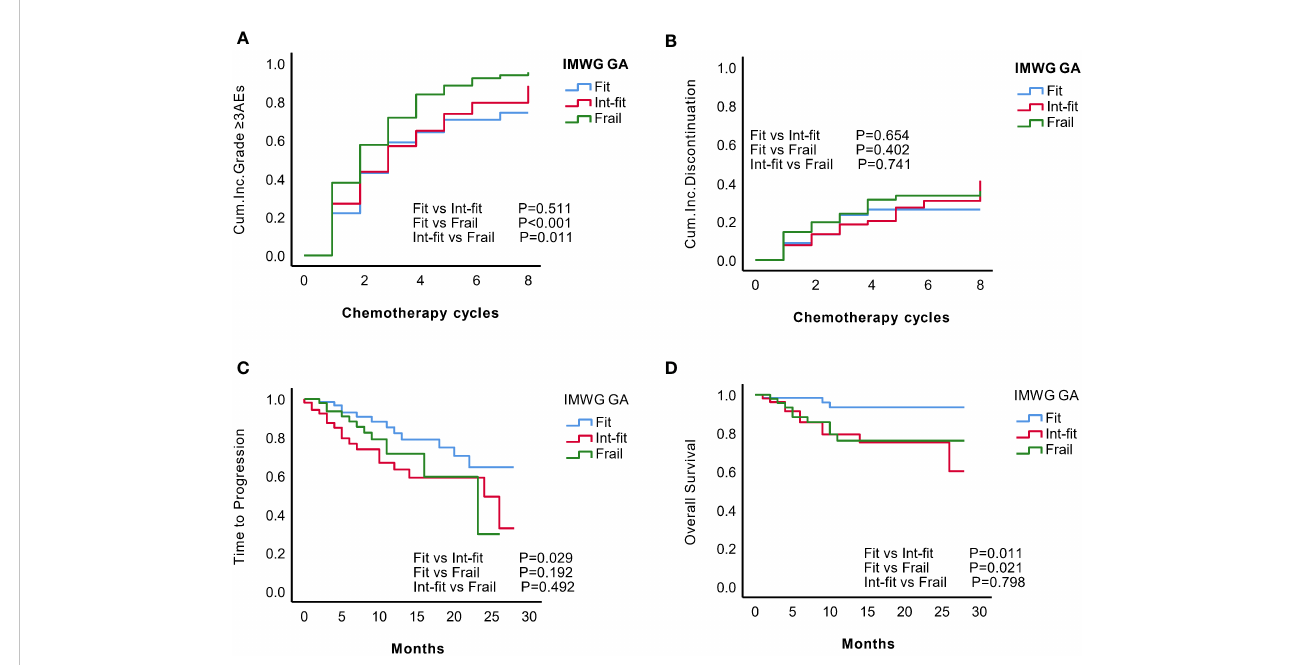
FIGURE 1 KM analysis of grade ≥ 3 AEs, treatment discontinuation, time to progression (TTP) and overall survival (OS) according to the IMWG GA subgroups. According to the IMWG GA evaluations, the patients were classi fi ed as fi t, int- fi t, or frail. The three subgroups were compared according to the (A) cumulative incidence of grade ≥ 3 AEs; (B) cumulative incidence of treatment discontinuation; (C) TTP; and (D)